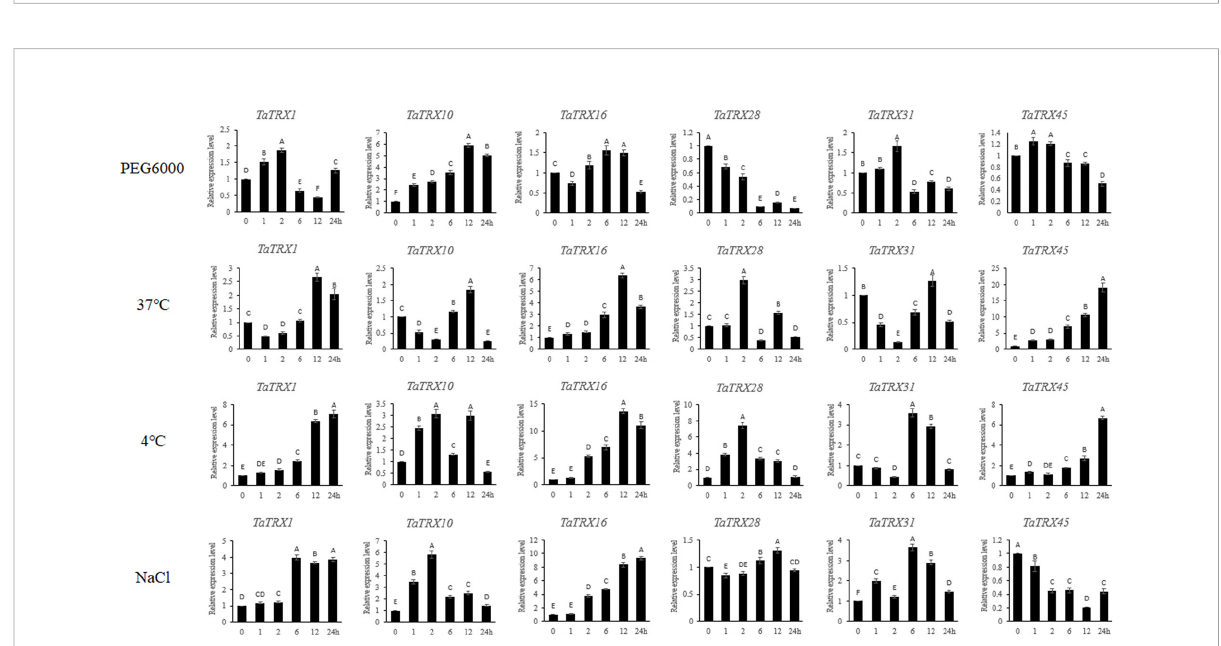
FIGURE 10 Expression analyses of typical TaTRX genes in wheat variety Chinese Spring (CS) under different treatments by RT-qPCR. Relative expression levels of typical TaTRXs in response to PEG 6000 (20%), heat (37°C), cold (4°C) and NaCl (200 mM) for 0 h, 1 h, 2 h, 6 h, 12 h, and 24 h in the leaves at the two-leaf stage. Data were normalized with b -actin gene. Vertical bars indicate standard deviations. Different capital letters indicate extremely signi fi cant differences at p < 0.01 according to one-way ANOVA and post-hoc Tukey ’ s test.